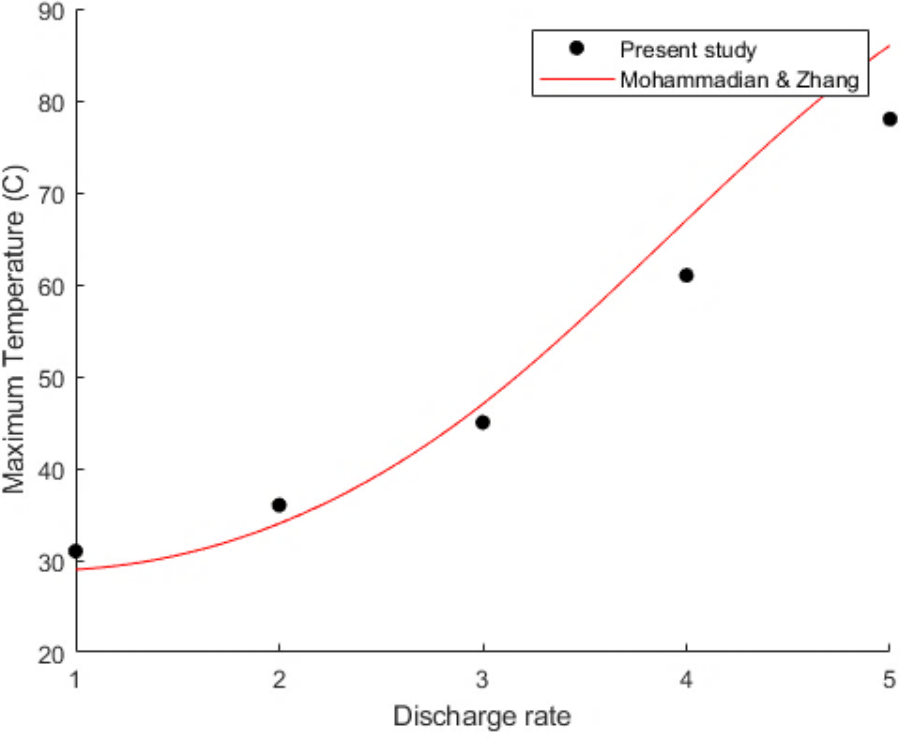
Figure 6. Model validation using battery maximum temperature at t =